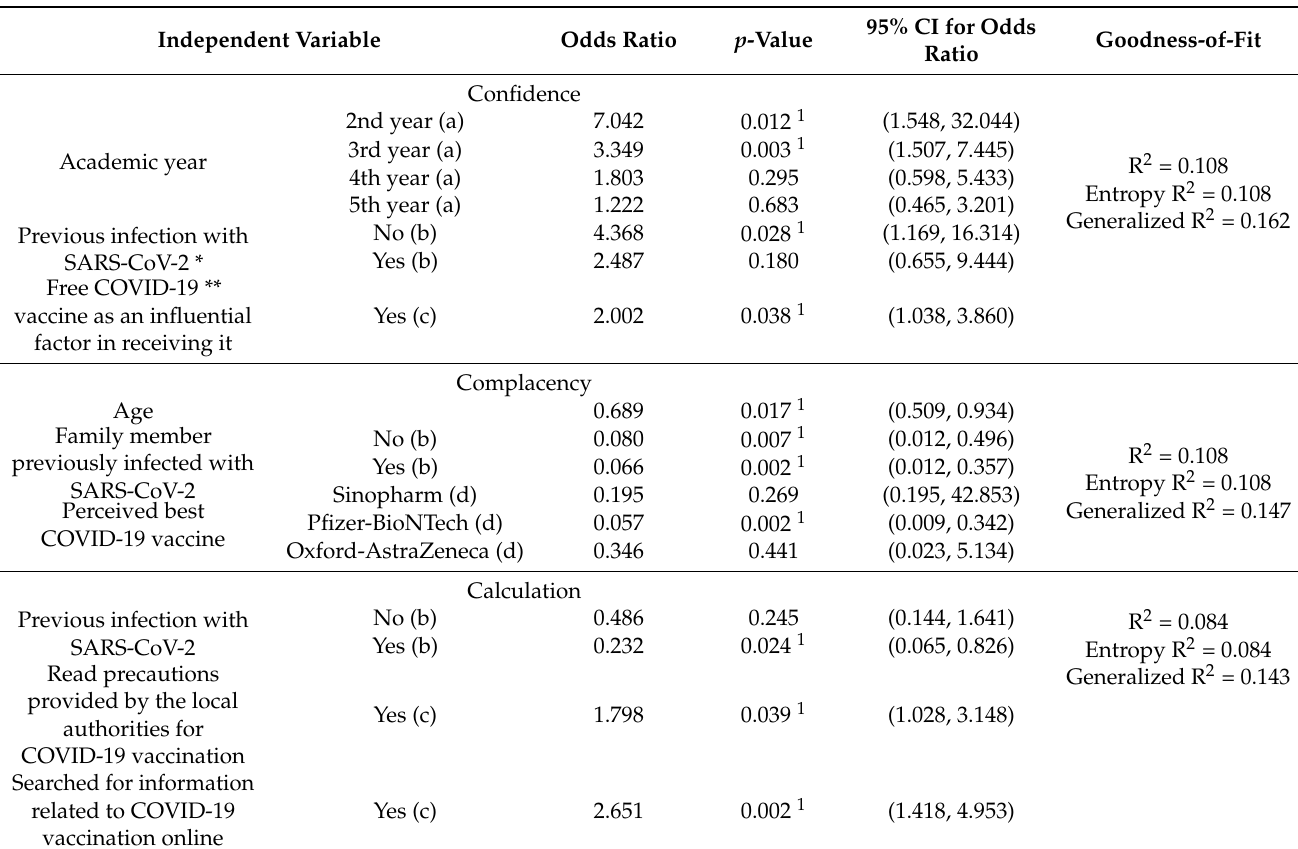
Table 8. Logistic regression